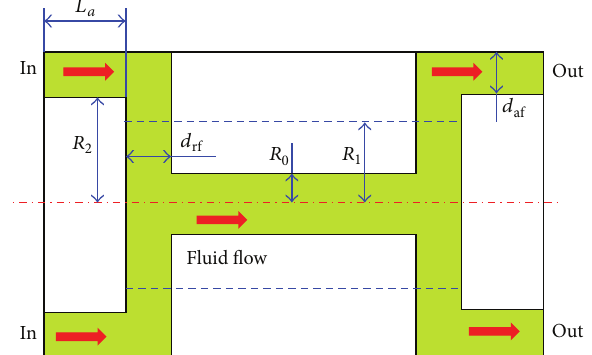
Figure 22: MR valve model with both annular and radial fluid flow paths.